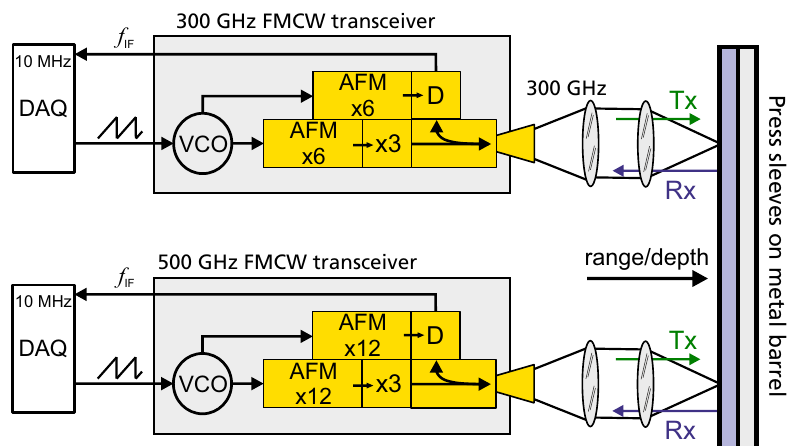
Figure 1. Schematic of the FMCW terahertz transceivers. Linear voltage ramps from a data acquisition unit’s (DAQ) analog output drive the voltage controlled oscillators (VCOs) at frequencies from 12 to 18 GHz for the 300 GHz and 9 to 15 GHz for the 500 GHz system, respectively. The frequencies are then multiplied in waveguide component-based multiplier chains to the desired target frequencies of 230 to 320 GHz and 350 to 510 GHz. We use waveguide horn antennas in combination with quasi-optical lens systems to focus the outgoing radiation (Tx) onto the press sleeves. The reflected radiation (Rx) is collected by the same quasi-optics and guided to Schottky-diode receivers and mixed with the VCOs reference output ramps. The generated difference frequency signals are sampled by 10 MHz ADC input channels of the